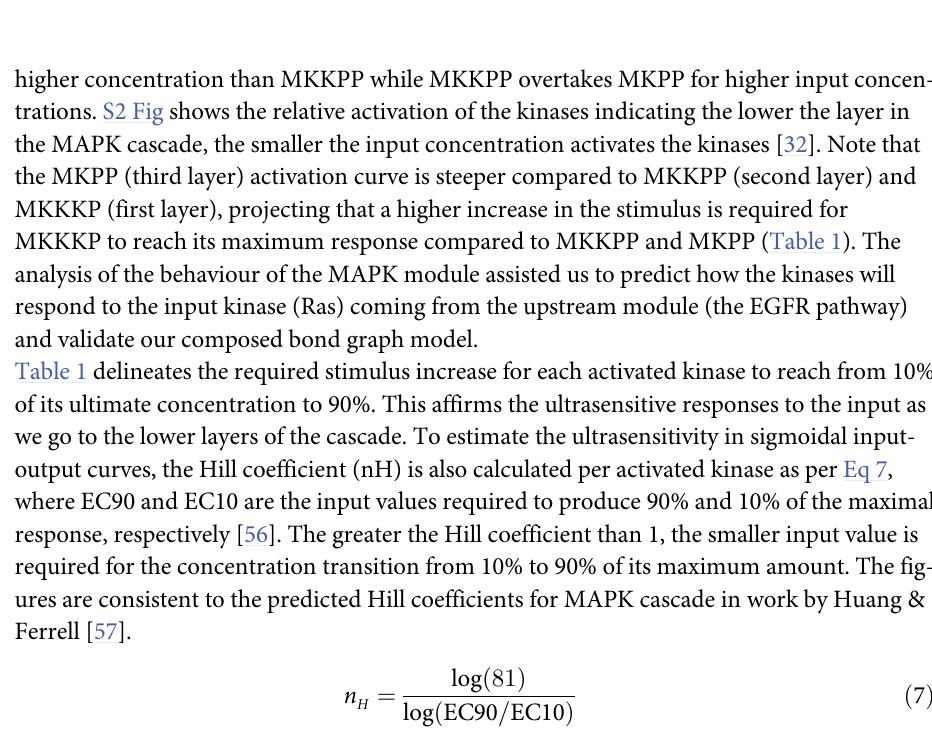
Table 1 delineates the required stimulus increase for each activated kinase to reach from 10% of its ultimate concentration to 90%. This affirms the ultrasensitive responses to the input as we go to the lower layers of the cascade. To estimate the ultrasensitivity in sigmoidal input- output curves, the Hill coefficient (nH) is also calculated per activated kinase as per Eq 7, where EC90 and EC10 are the input values required to produce 90% and 10% of the maximal response, respectively [56]. The greater the Hill coefficient than 1, the smaller input value is required for the concentration transition from 10% to 90% of its maximum amount. The fig- ures are consistent to the predicted Hill coefficients for MAPK cascade in work by Huang & Ferrell [57].